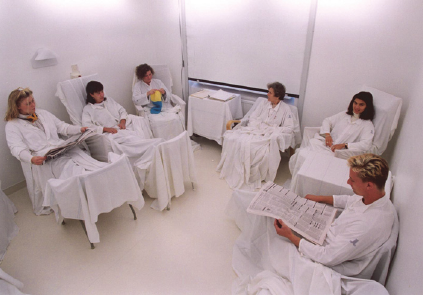
Figure 1: Illustration of light treatment in a room comparable to those used in the present study. Volunteers from the medical staff haveinthephotographreplacedthepatientstokeeptheparticipants’ privacy (by consent of the photographer Stig-G¨oran